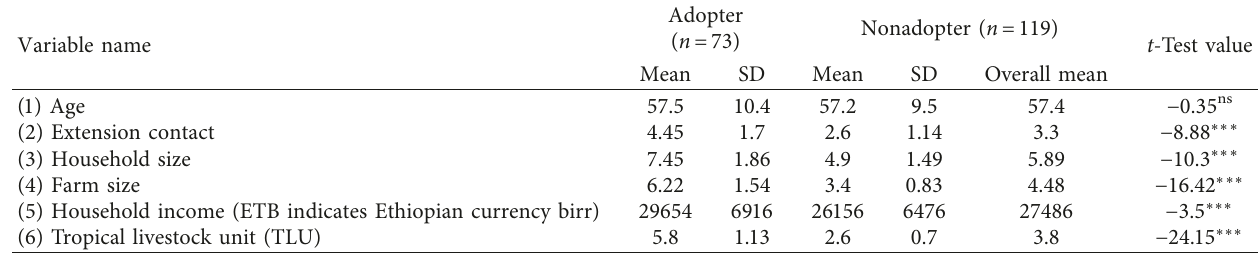
Table 1: Comparison between key socio-economic characteristics by adoption